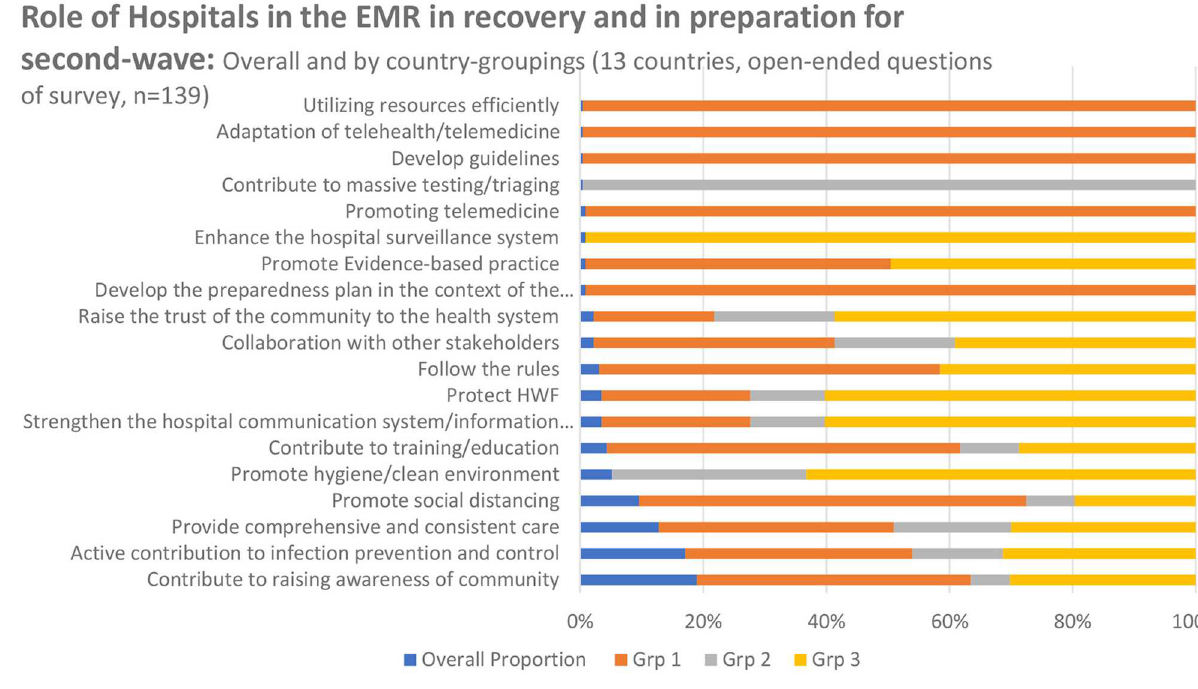
FIGURE1 Survey responses ranking role of hospitals, in the EMR, in recovering from COVID-19; by country group and overall.